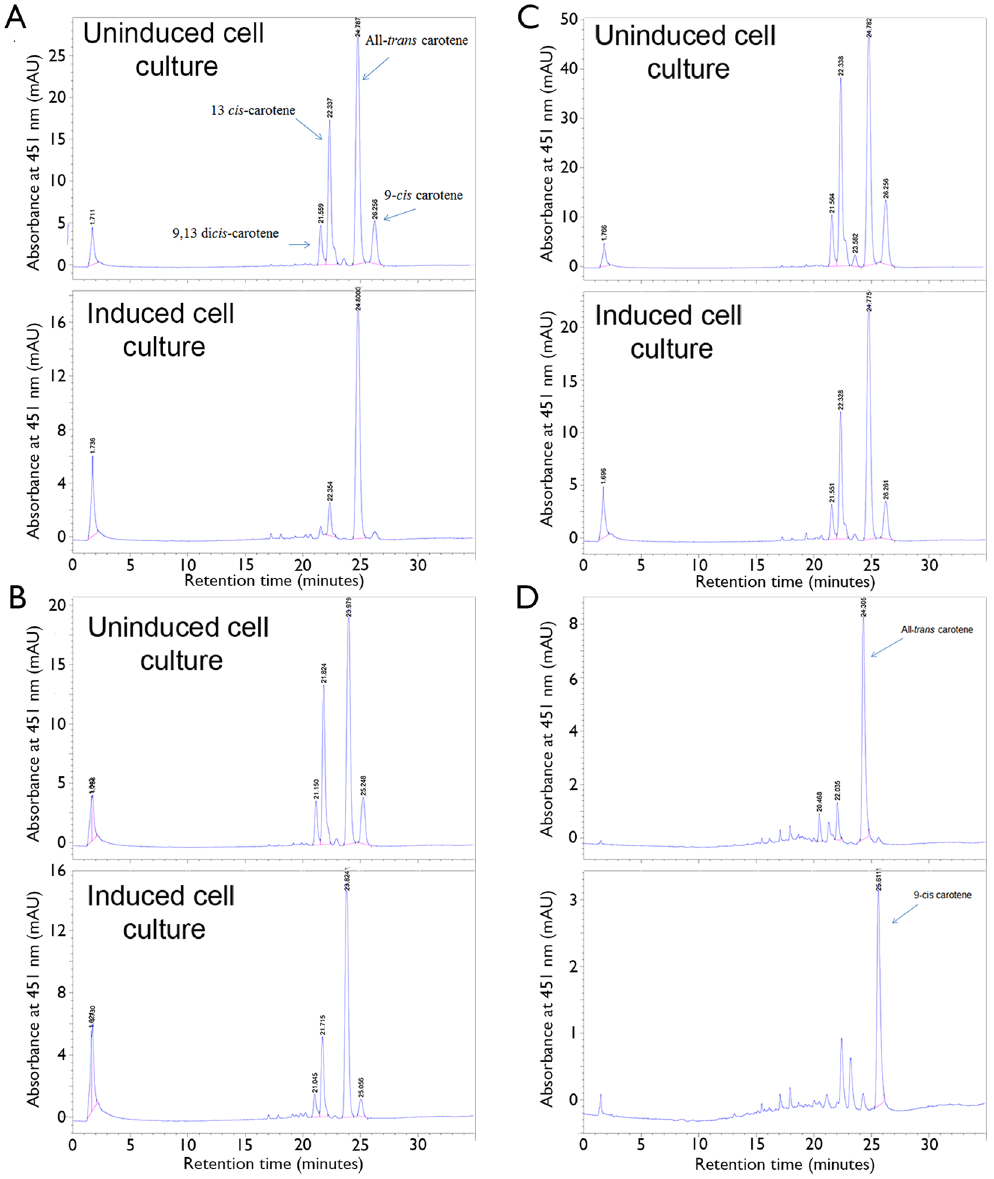
Figure 4. Reverse phase HPLC analysis of β -carotene cleavage by Lancelet BCOLg ( A ), lanBCOa ( B ), lanBCOc ( C ). HPLC profile of all- trans β -carotene and 9- cis β -carotene are presented in D panel.